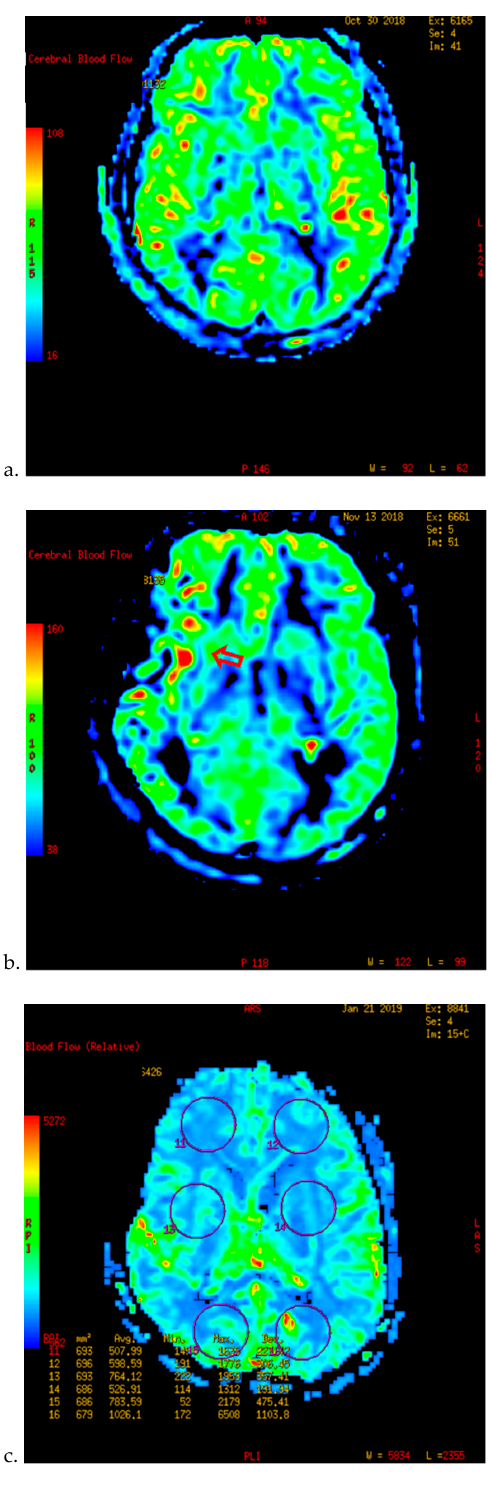
Figure 1. PWI of patients with TND in the perioperative period after operation (example 1). ( a ) The PWI image on the day before operation showed that the cerebral blood flow (CBF) of both sides was basically the same. ( b ) On the 7th day after right combined revascularization, the patient developed epileptic symptoms. PWI examination showed that the CBF in the right operating area was significantly higher than that in the contralateral side on the 13th day after operation. ( c ) The patient’s TND symptoms recovered after more than ten days of repeated attacks. Two months after discharge, PWI showed that the cerebral blood flow of the two hemispheres tended to